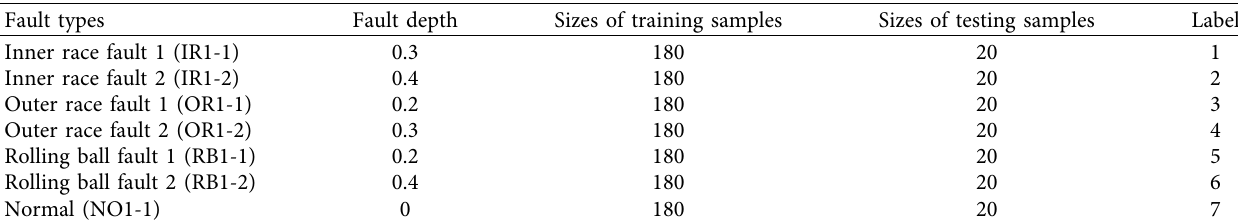
Figure 4: The diagram of the rolling bearing test rig. Table 1: Description of the operation conditions in experiment 1.